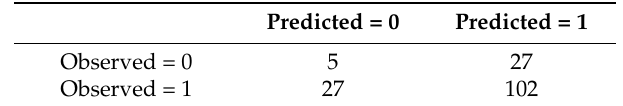
Table 4. Validation of the model predicting non-vigorous (0) and vigorous (1) trees based upon differences in BAI -1-5 between the two tree vigor evaluations.